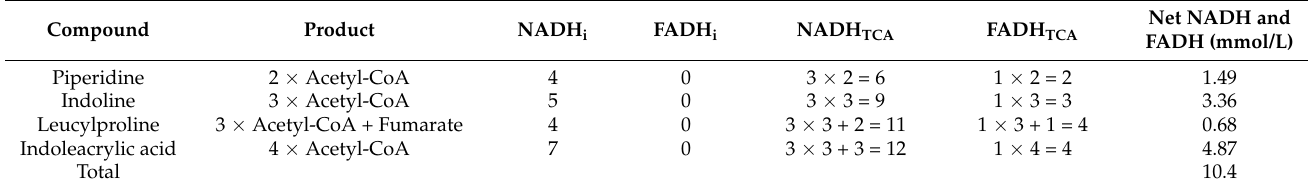
Table 4. Overall NADH production for the identified